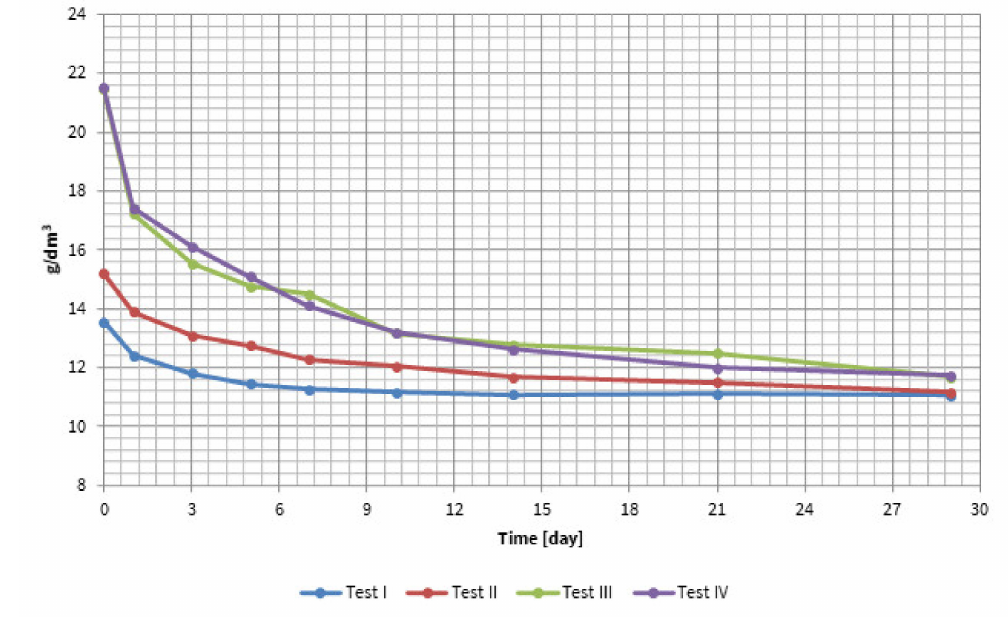
Figure 5. The course of changes in the content of VS during